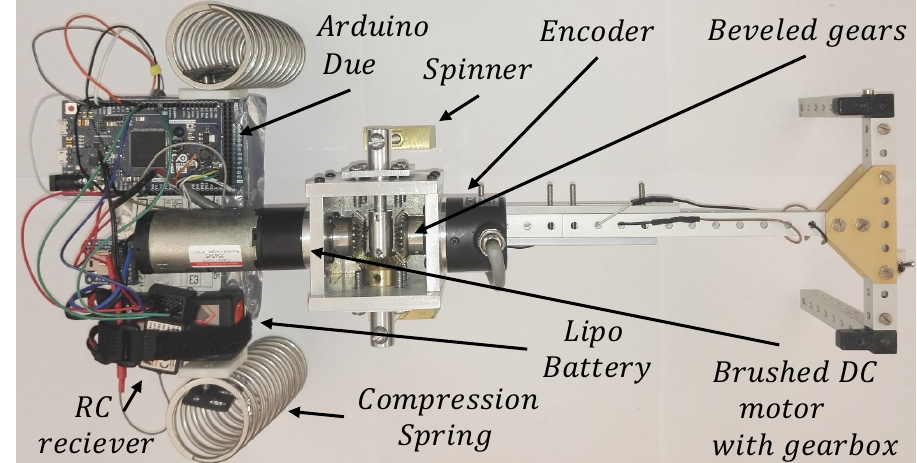
Figure 13. Top view of robot.